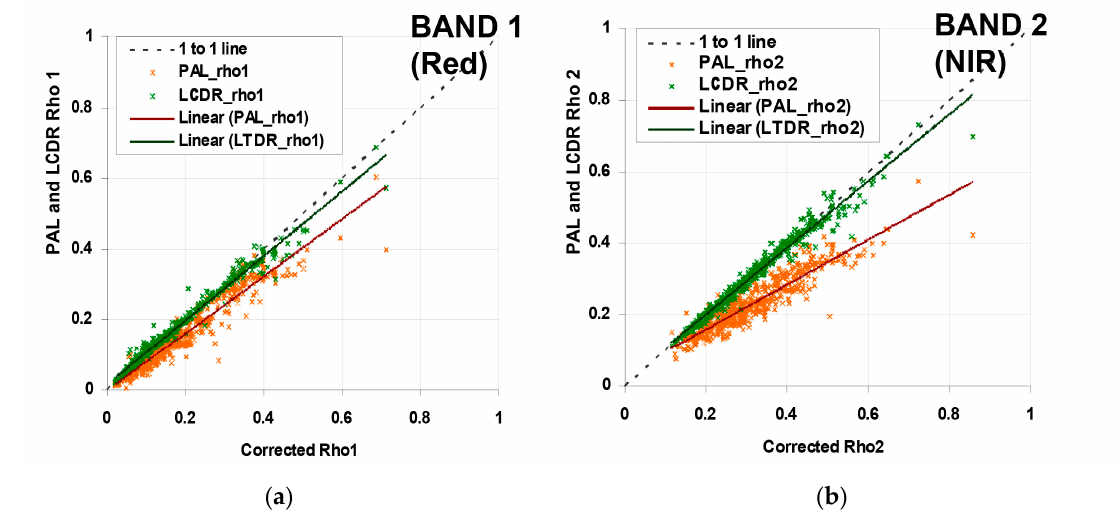
Figure 6. Comparison of current AVHHR Surface Reflectance (LCDR) and PAL data for channel 1 ( a ) and channel 2 ( b ) at 48 AERONET sites for 1999 (from [9]). The x -axis shows the surface reflectance values determined from the 6S code supplied with atmospheric parameters from an AERONET sun photometer, while the y -axis shows the surface reflectances retrieved from the AVHRR data using current LCDR and PAL algorithms.